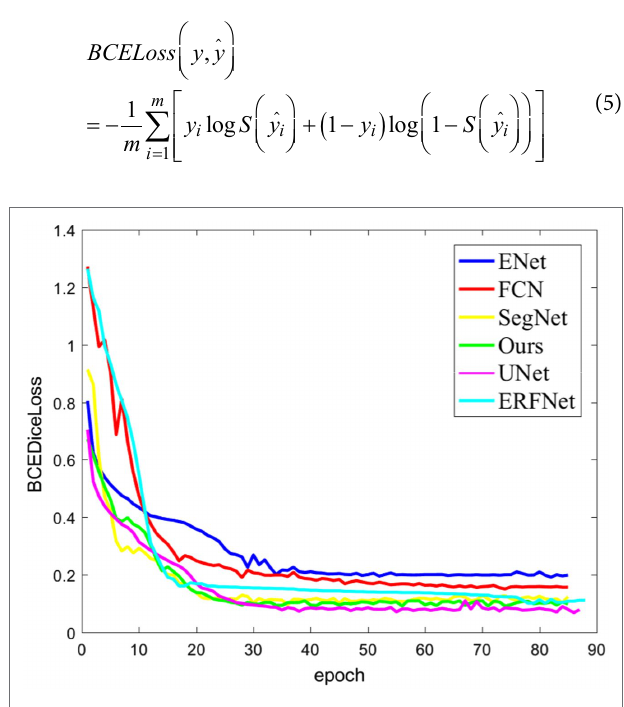
FIGURE 7 | Loss function